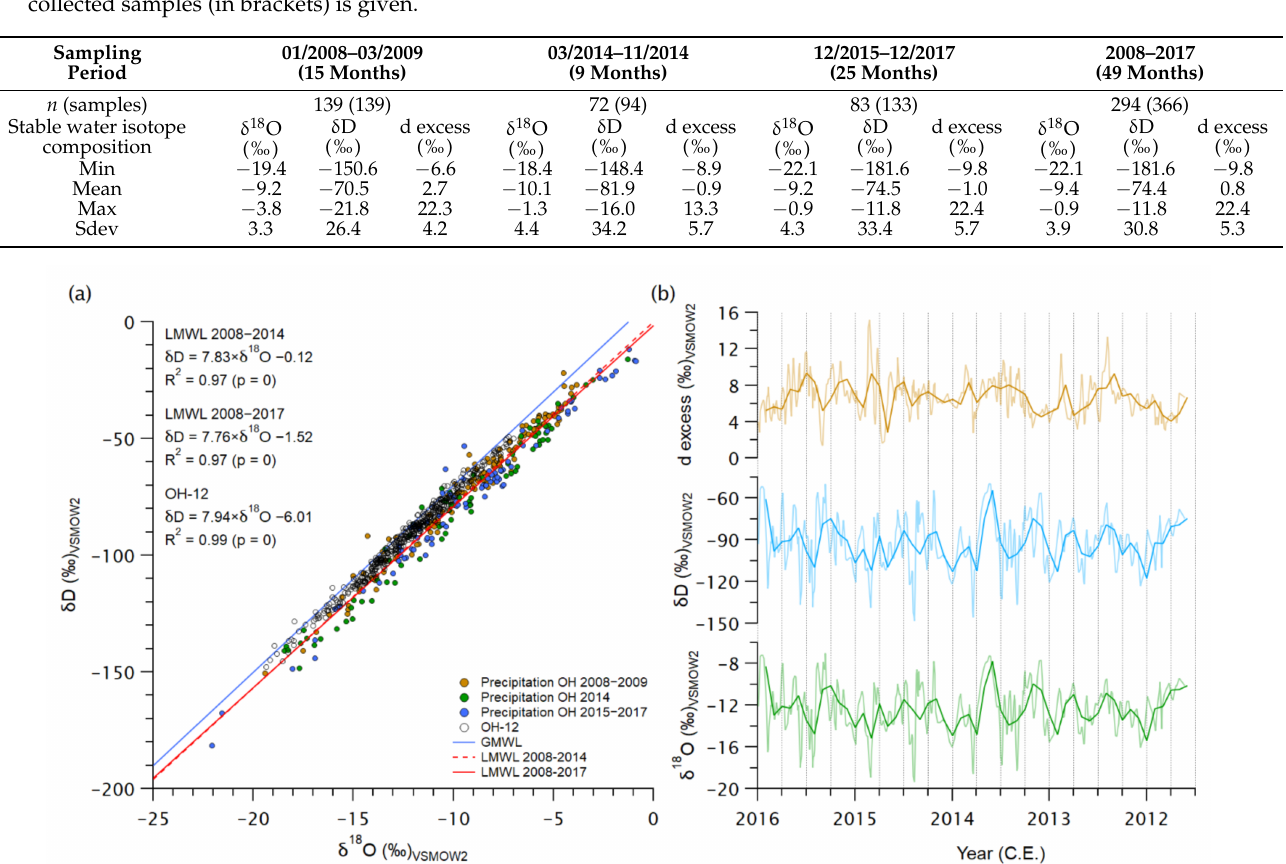
Table 2. Basic statistics of the stable water isotope composition of precipitation samples collected at Bernardo O’Higgins each sampling period the number of samples ( n ) considered for the statistical analysis together with the total number of collected samples (in brackets) is given.